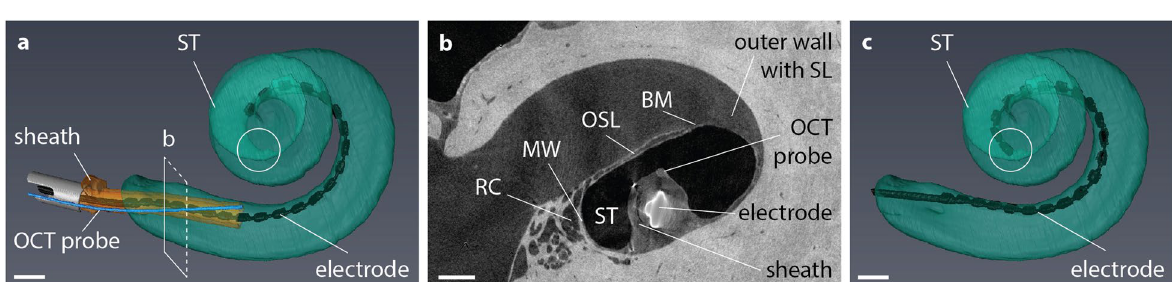
Figure 5. Intracochlear position of the optically-guided sheath and the slim modiolar electrode. ( a ) CECT- based 3D rendering of the optically-guided sheath together with the slim modiolar electrode inside the ST in sample #8. The rectangle indicates the position of the CECT section in ( b ). Circle indicates the final position of the electrode array tip, as shown in ( c ). ( b ) CECT cross-section showing the position of the optically-guided sheath within the ST with respect to the three critical cochlear walls. ( c ) CECT-based 3D rendering of the final electrode position inside the ST, after extraction of the optically-guided sheath. Note that all electrode contacts are perfectly positioned inside the ST in close proximity to the modiolar wall. The position of the electrode array tip is encircled. BM basilar membrane, MW modiolar wall, OSL osseous spiral lamina, RC Rosenthal’s canal, containing auditory nerve fibers, ST scala tympani. Scale bar: 1